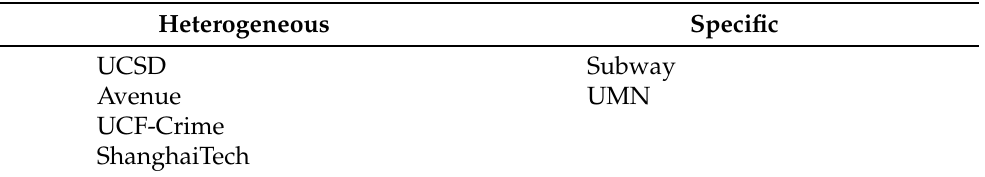
Table 7. Category of video surveillance